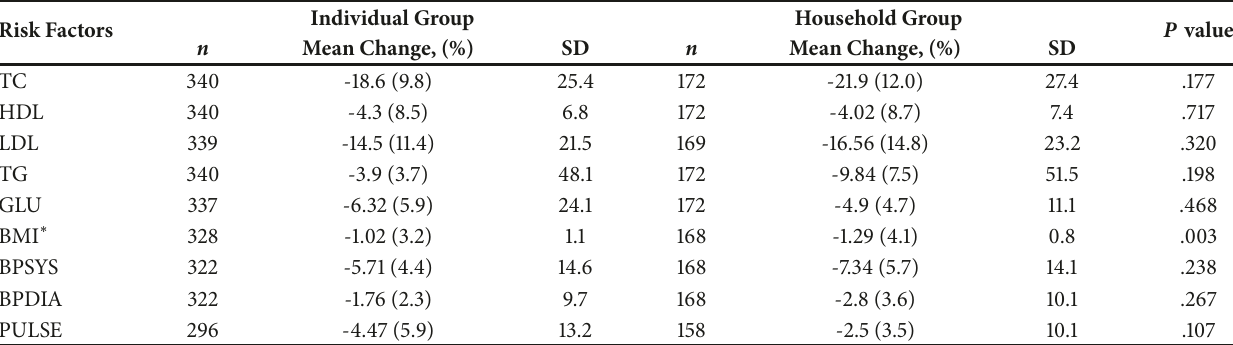
Table 3: Biomarker outcomes for CHIP participation alone (Individual) or with an accompanying household member (Household). Abbreviations. Standard deviation (SD), total cholesterol (TC), high density lipoprotein (HDL), triglycerides (TG), fasting blood glucose (GLU), body mass index (BMI), systolic blood pressure (BPSYS), and diastolic blood pressure